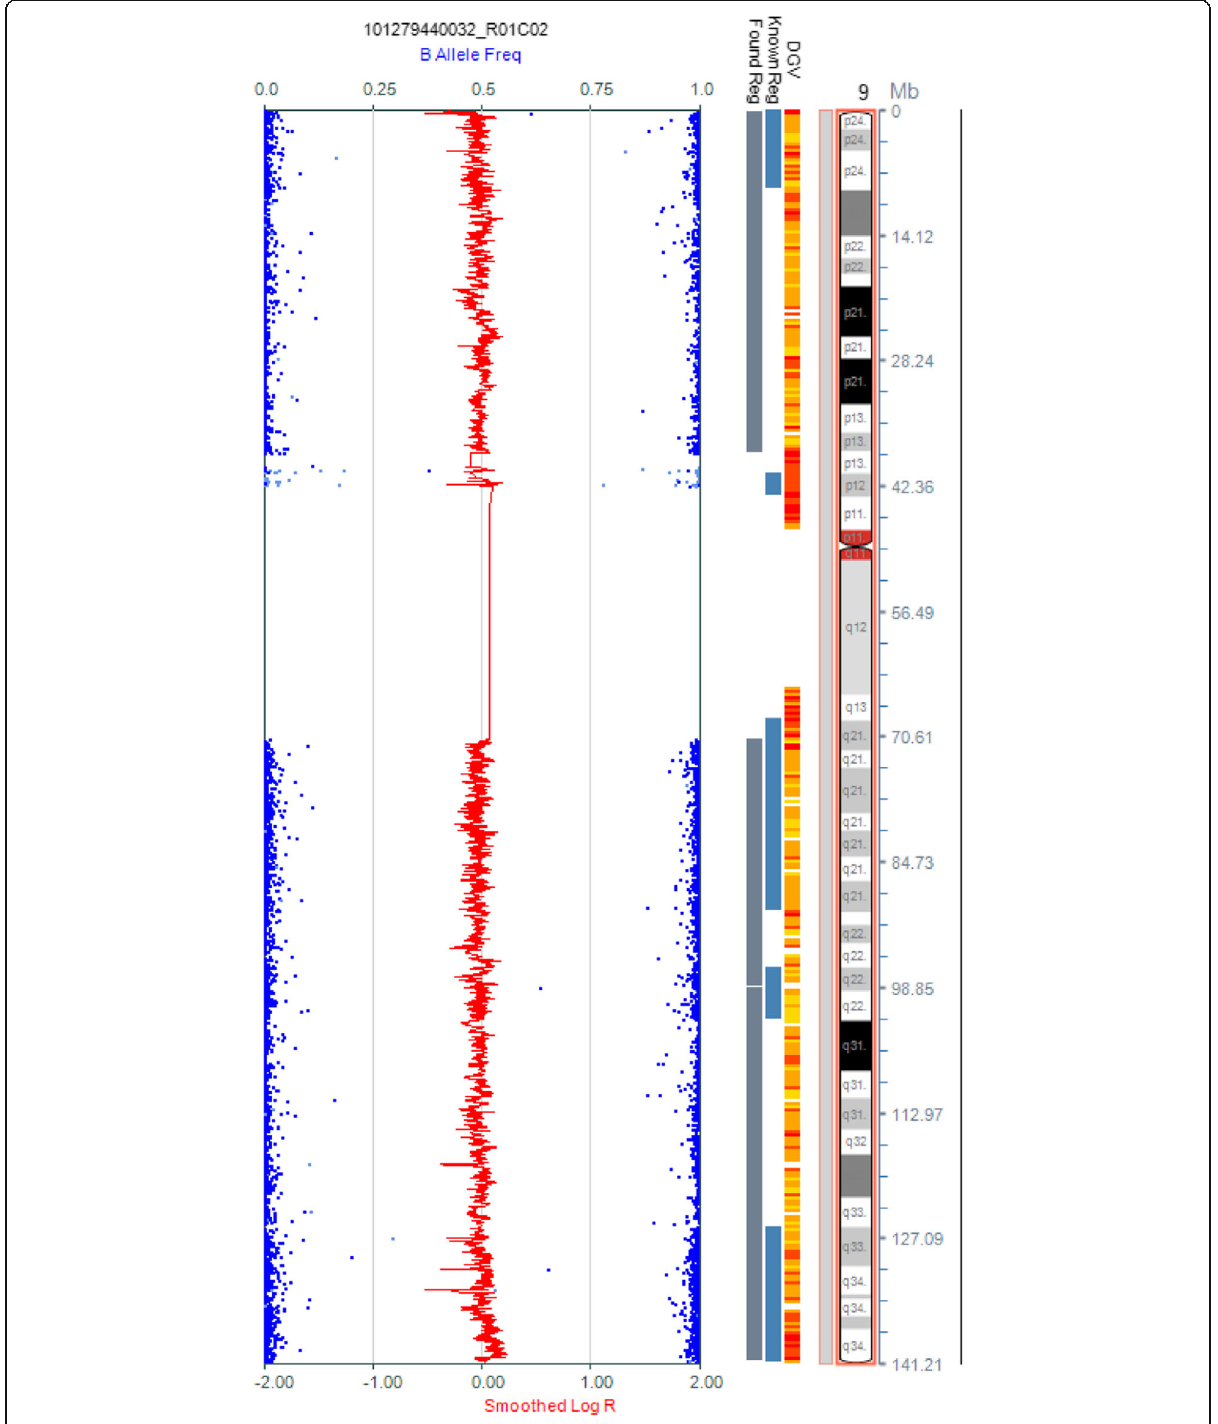
Fig. 3 The SNP-array results of the amniocentesis revealed 46, XY, iUPD